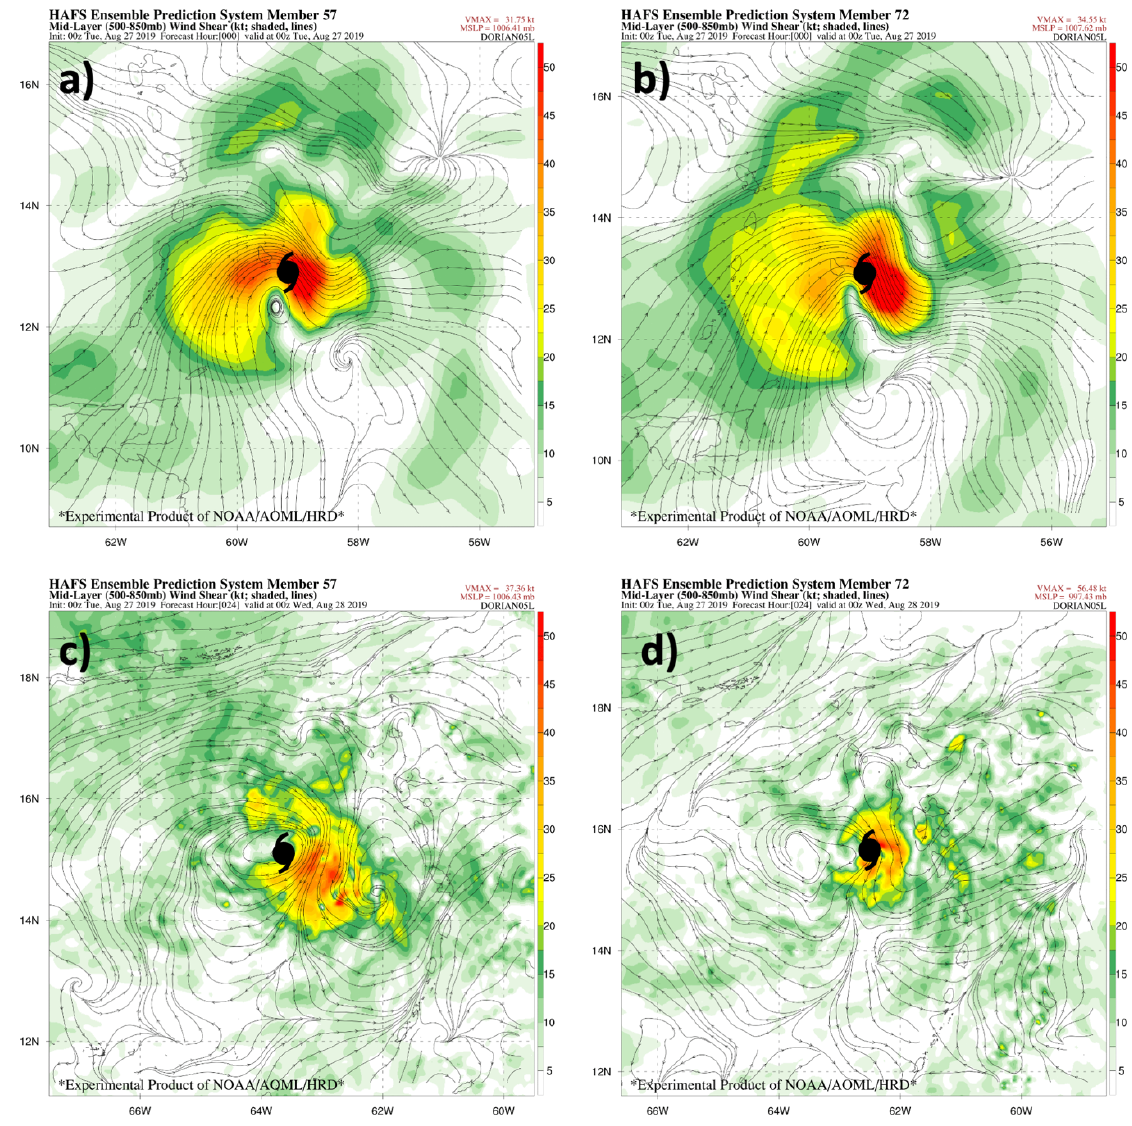
Figure 13. ( a ) 850–500 hPa shear (kt, 1 kt = 0.51 m s − 1 , shaded and streamlines) and wind (kt, wind barbs, 1 kt = 0.51 m s − 1 ) at 0 h for the weak member. The black hurricane symbol shows the forecast position of Dorian. ( b ) As in ( a ), but for the strong member. ( c ) As in ( a ), but for 24 h. ( d ) As in ( b ), but for 24 h.